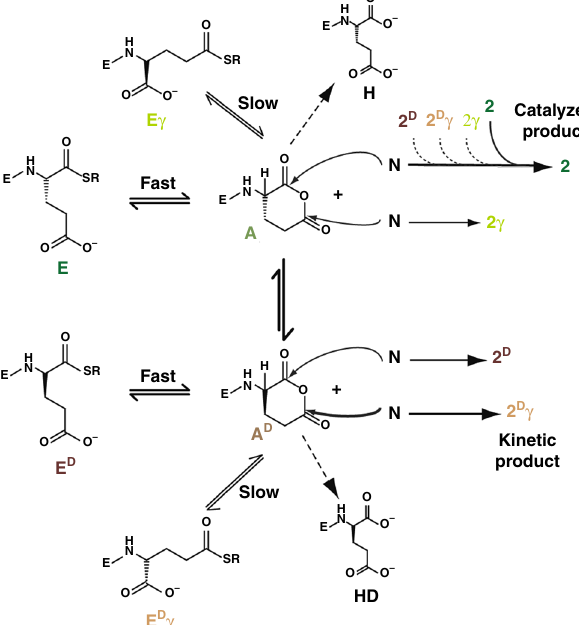
Fig. 5 General mechanism of a network reaction initiated by N and any one of the electrophiles Ex . The scheme illustrates the central role of the glutaric anhydride intermediates A and A D in the dynamic exchange between the starting material and the product isomers, as well as the kinetically favored pathways leading to product 2 D γ and the catalyzed pathways leading to product 2 containing the native